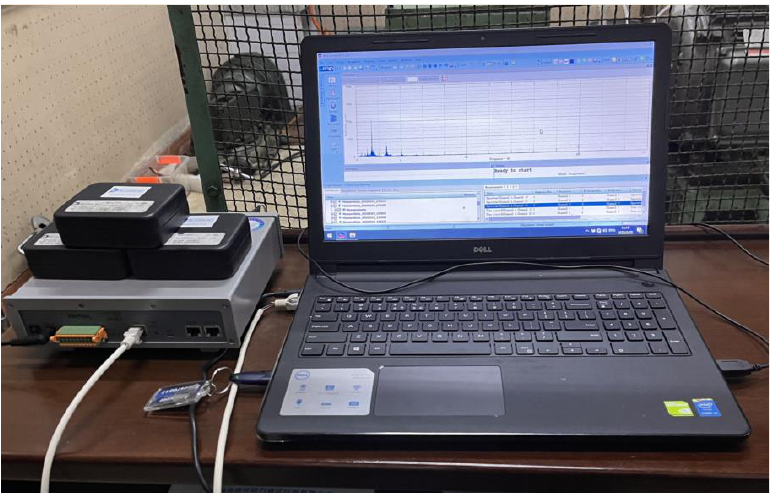
Figure 2. M + P vibration tester.